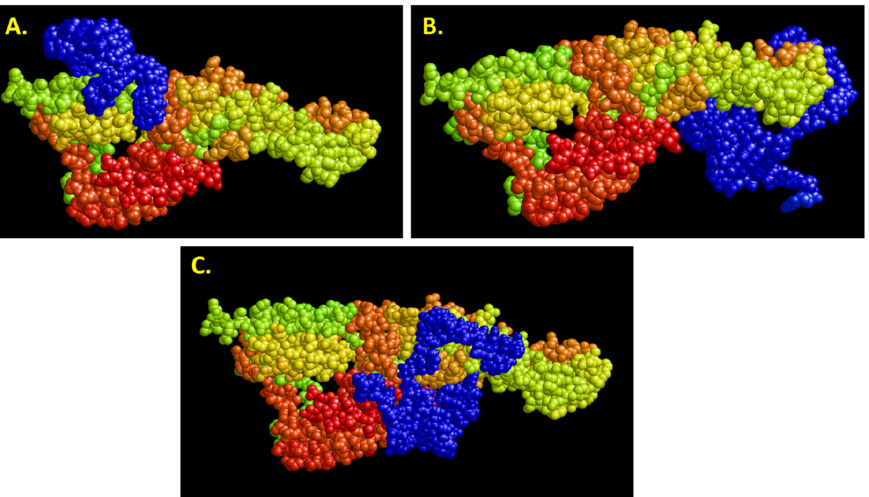
Figure 11. Analysis of binding sites on the Hanta virus envelope protein (multicolored) by the same blue DNA aptamer as predicted by the top scored docking model for ( A ) HDOCK, ( B ) ZDOCK and ( C ). PatchDock with clearly different optimal binding sites based on each program’s specific shape complementarity algorithm [31–33].